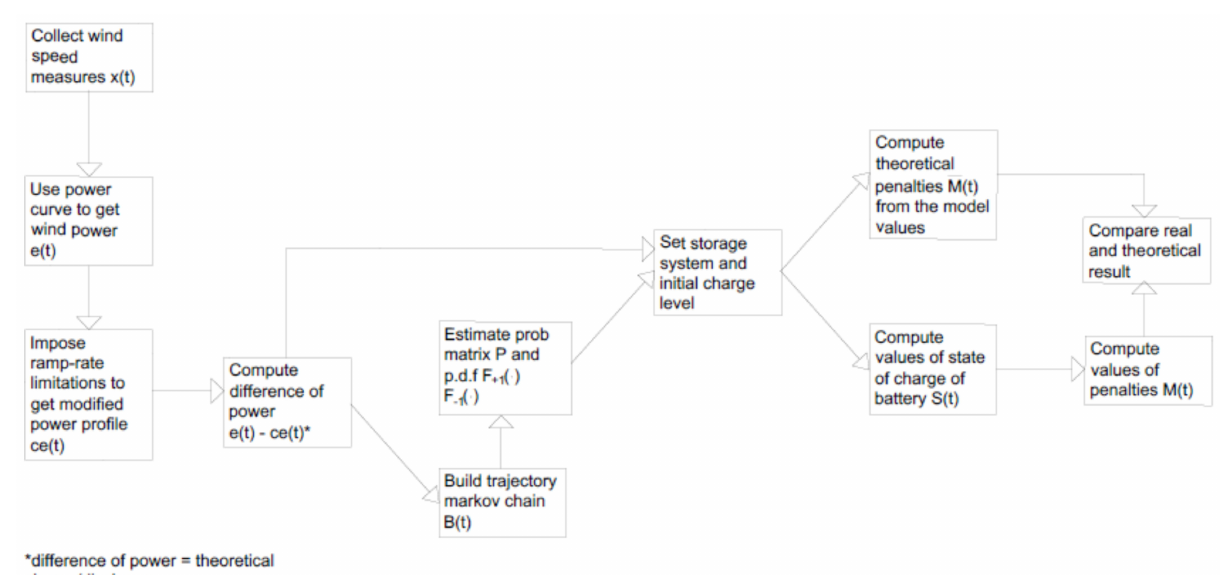
Figure 4. Block diagram summarizing the model